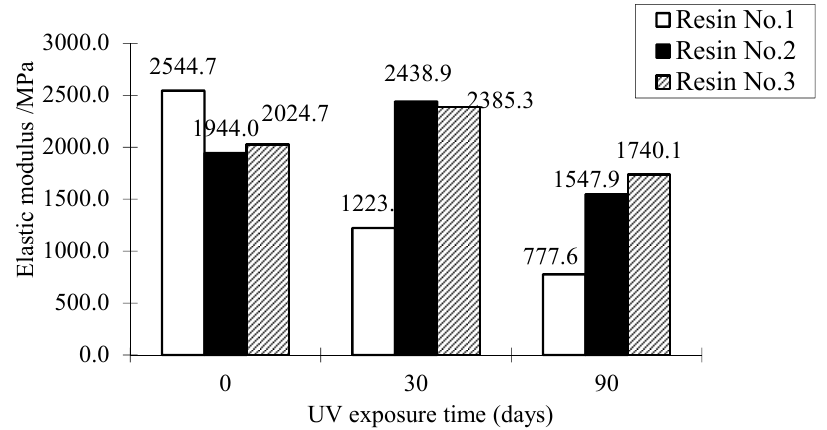
Figure 13. Effect of UV exposure on the elastic modulus of resin 3.3. Concrete degradation after UV exposure.